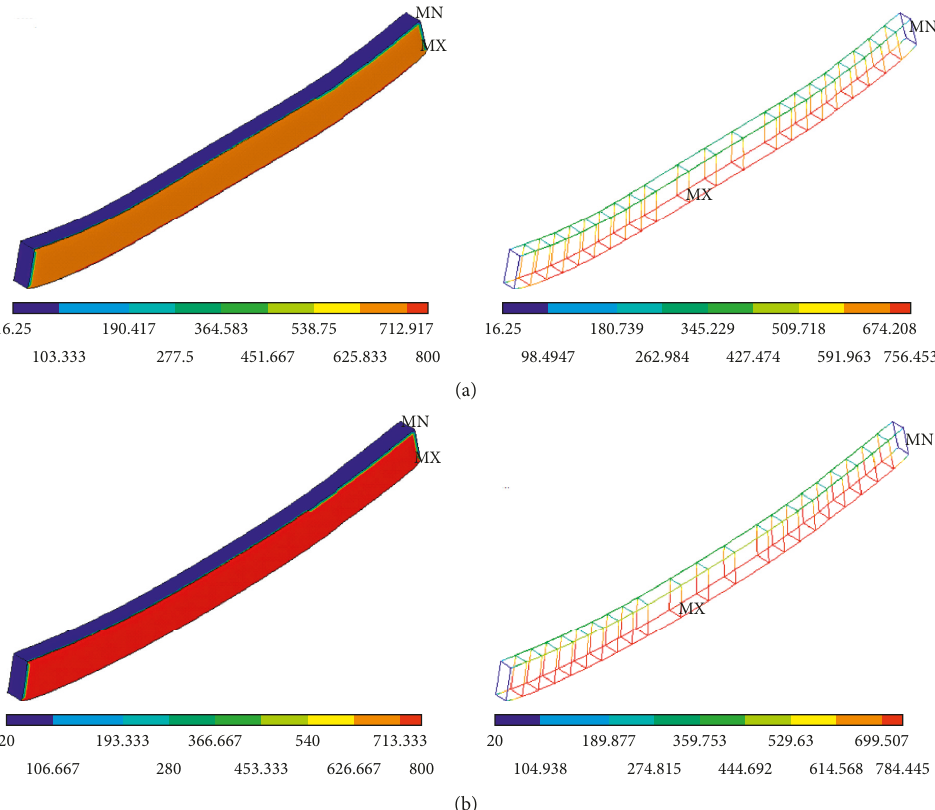
Figure 11: Thermal stress contour at different time (200 mm